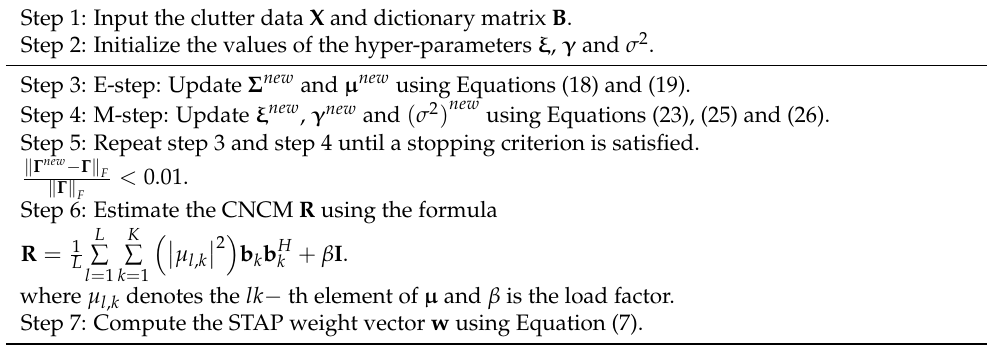
Table 1. Pseudocode for M-GDP—STAP algorithm.